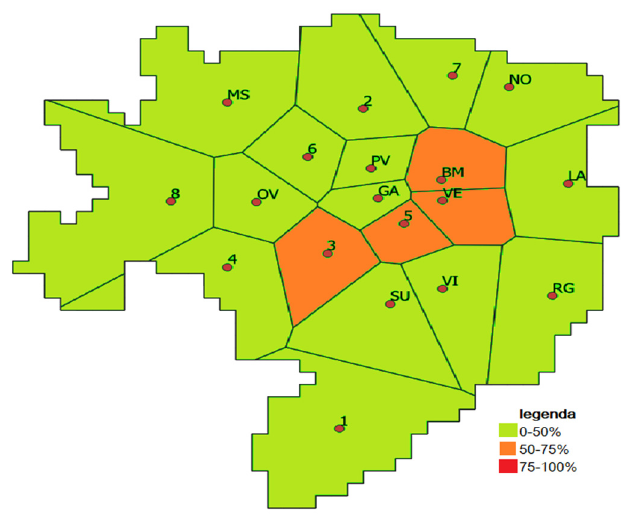
Figure 23. PSs service areas considering eight incremental PS. The colors report the power demand from the PS transformers’ nominal power.